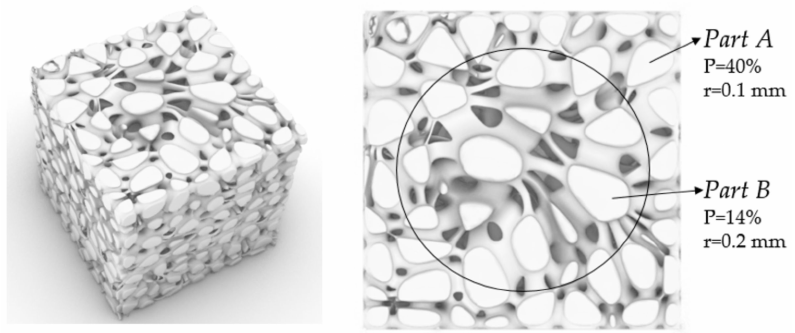
Figure 24. A gradient structure with gradient porosity and pores.